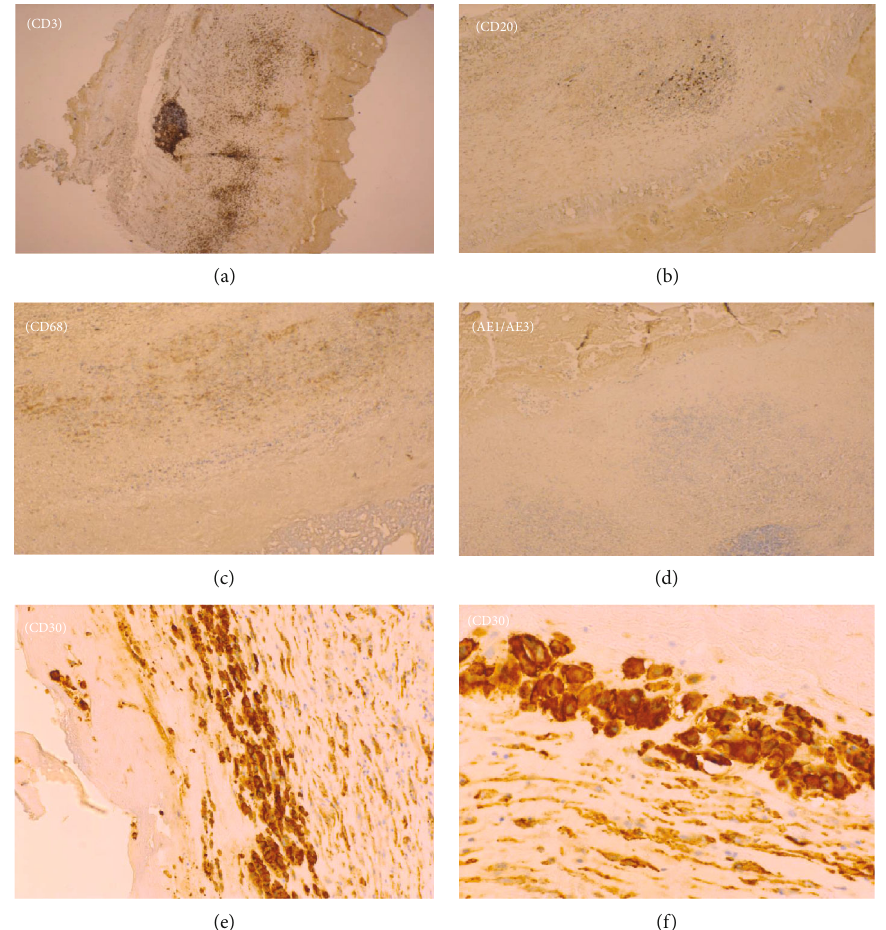
Figure 3: (a – f) Immunohistochemical staining of the right breast peri-implant capsule with exudate. The malignant lymphoid cells stain positively for CD30 and are negative for CD3, CD20, CD68, and